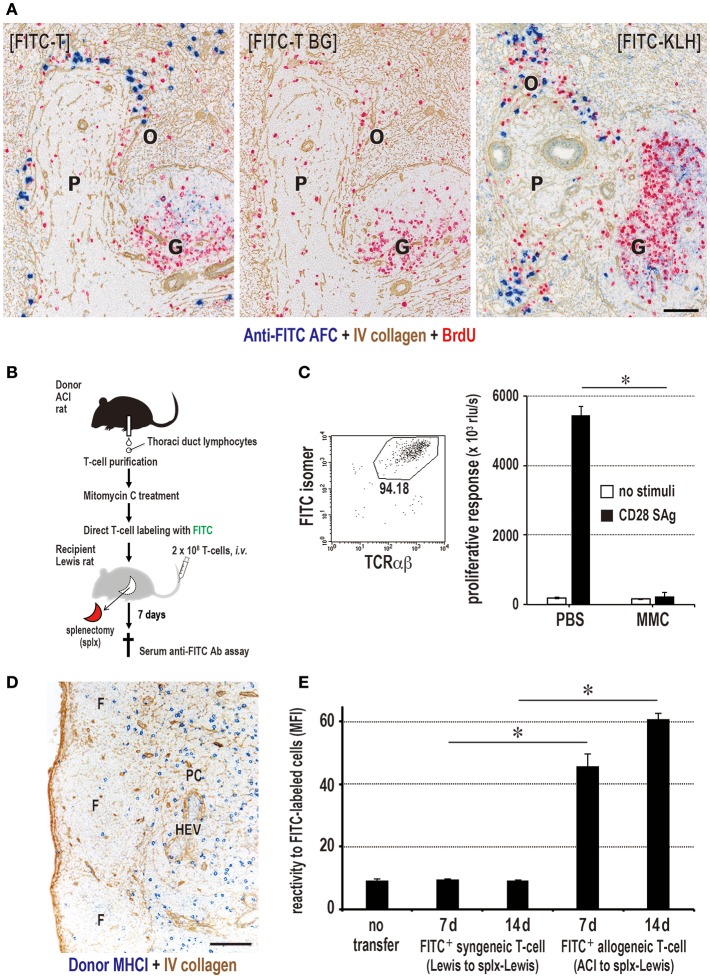
Antigen-labeled donor T cells induce specific antibody production. (A) Three-color immunostaining of recipient spleen for anti-FITC antibody (blue), type IV collagen (brown), and BrdU (red). FITC-T cells induced specific anti-FITC antibody forming cell response (blue) in the outer margin of the PALS (O) at 7 days after injection [FITC-T]. When FITC-streptavidin was omitted for background staining, anti-FITC antibody was not detected [FITC-T BG]. Positive control staining for anti-FITC antibody forming cells 5 days after i.v. injection of FITC-labeled KLH [FITC-KLH]. G, germinal center; P, PALS. Scale bar = 100 μm. (B) Experimental protocol for inducing antibody production in LNs with FITC-labeled donor T cells. (C) Effect of mitomycin C (MMC) on FITC-labeled donor T cell proliferation. Purity of FITC-labeled donor T cells was 94% by FCM. The proliferation of MMC-treated T cells induced by CD28 superagonist (SAg) was abrogated compared to intense proliferation in PBS-treated control. (D) Two-color immunostaining for donor MHCI (blue) and type IV collagen (brown) in the LNs 1 d after injection of MMC-treated FITC-labeled donor T cells. They readily migrated to the T cell area of the LNs (paracortex, PC). F, lymphoid follicle; HEV, high endothelial venule. Scale bar = 100 μm. (E) MMC-treated FITC-labeled allogeneic, but not syngeneic, T cells induced a low, but significant, antibody response to FITC. (C,E) mean ± SD, n = 3 rats each, *P < 0.05. MFI, mean fluorescent intensity.